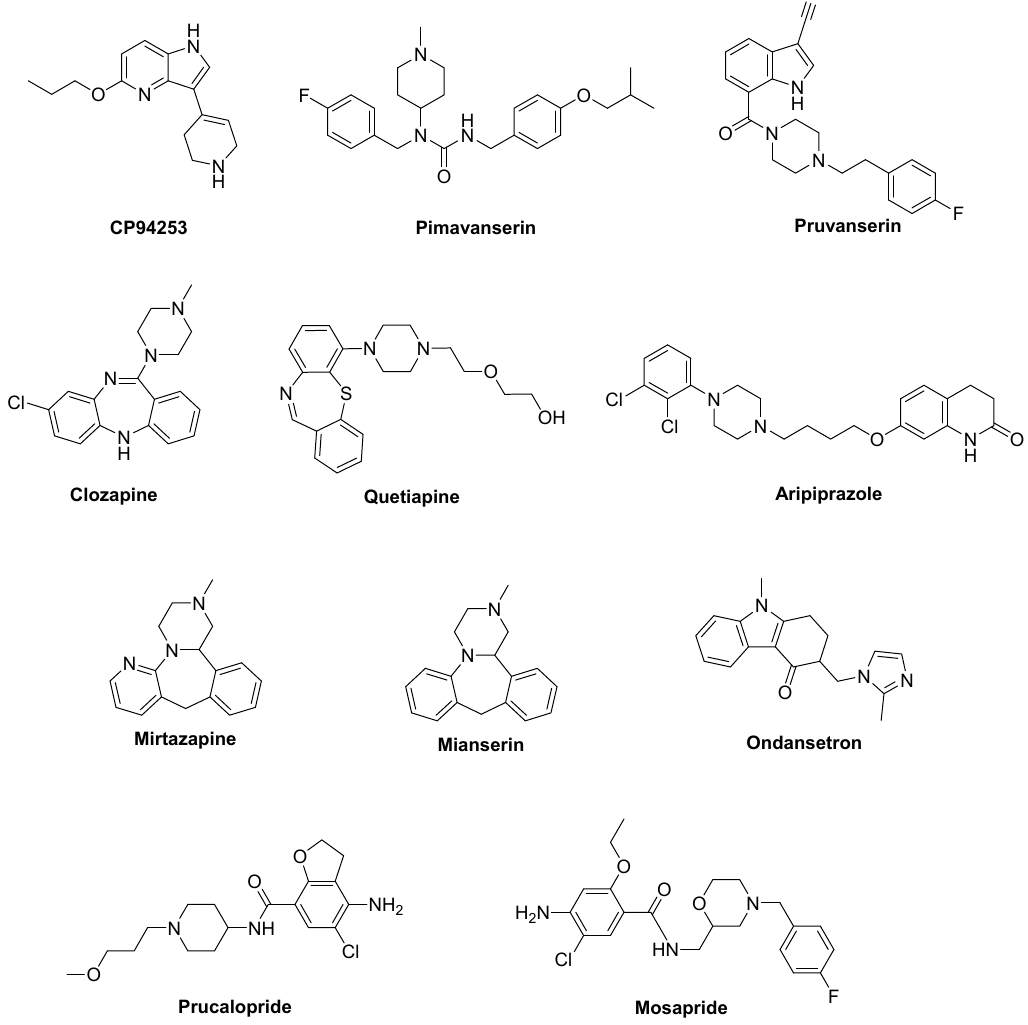
Figure 4. 5 ‐ HT 1B R, 5 ‐ HT 2A R, 5 ‐ HT 3 R, and 5 ‐ HT 4 R ligands. Figure 4. 5-HT 1B R, 5-HT 2A R, 5-HT 3 R, and 5-HT 4 R